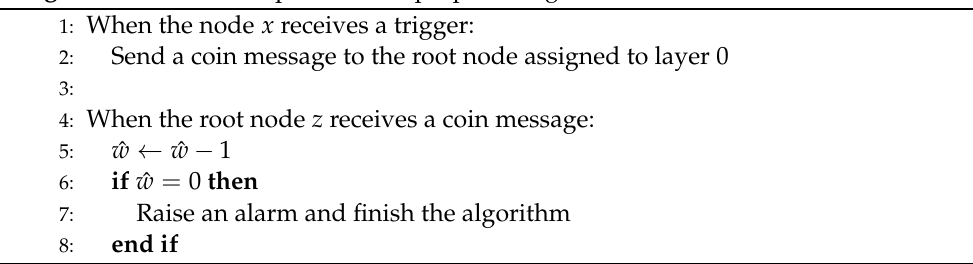
Algorithm 3: The third phase of the proposed